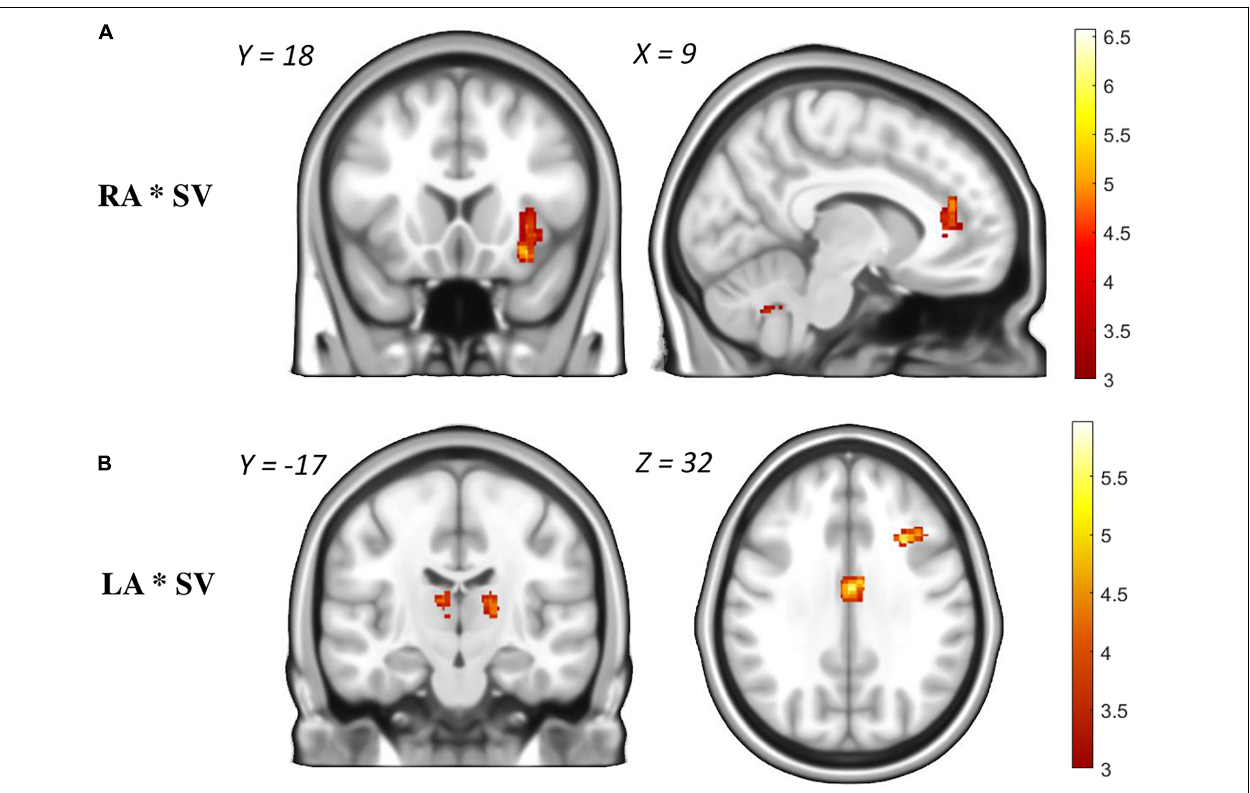
FIGURE 5 | Parametric modulation of brain activation during the anticipation phase with hyperbolic model-derived subjective values (“see Behavioral Modeling”). (A) : Brain regions that show more activation during Reward Anticipation (RA) when subjectively higher rewards could be won. (B) : Brain regions that show more activation during Loss Anticipation (LA) when subjectively higher losses could be avoided. Only voxels from significant clusters (cluster-size p < 0.05 corrected for multiple testing and p < 0.001 as cluster-defining threshold) are